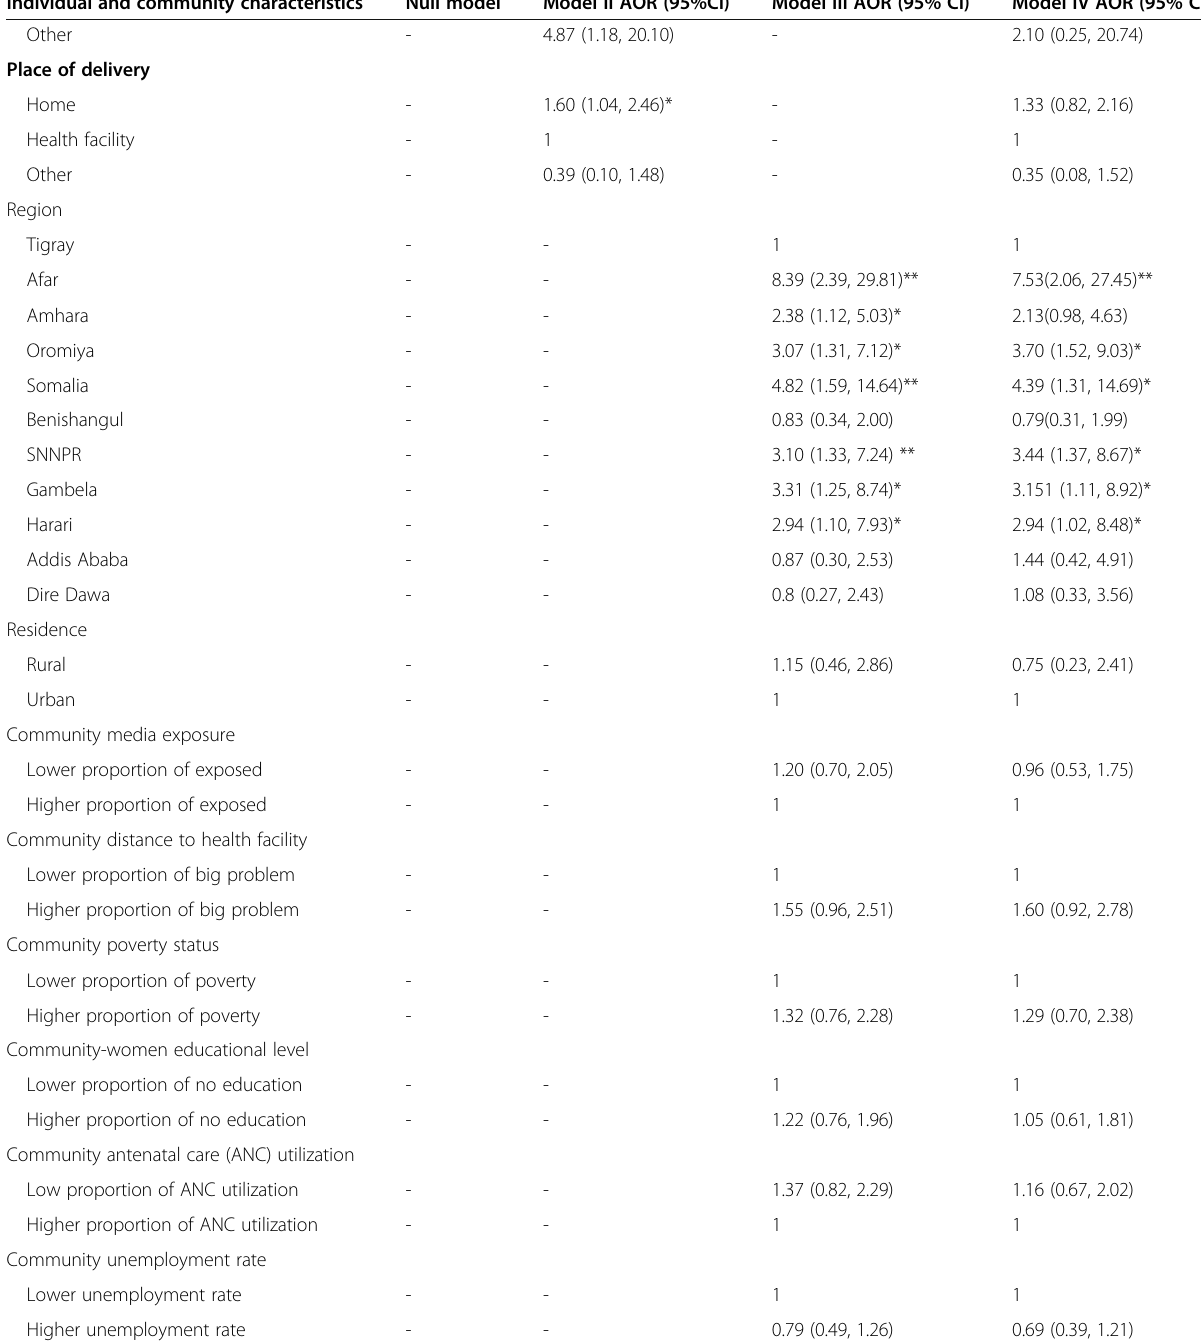
Table 4 Multilevel binary logistic regression analysis of individual- and community-level factors among children aged from 12 to 23 months in EDHS 2016 (Continued) Individual and community